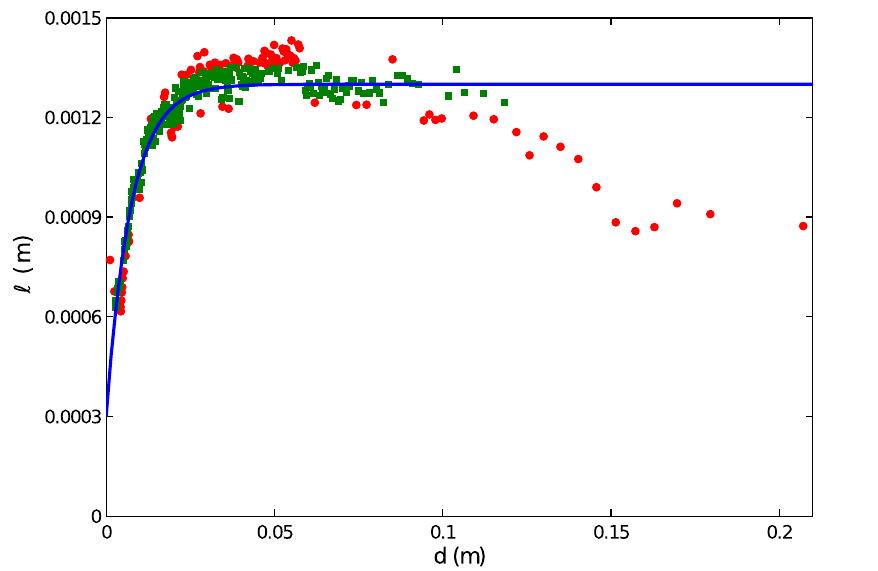
Figure 3. Correlated random walk step length ‘ (in m ) per frame as a function of distance to an aphid’s nearest neighbor d (in m ). Each data point represents the mean step length within a bin of 800 elements from our experimental data set, where the data are binned by d . The overall dependence of the data on d is modeled with Eq. (5), which captures the tendency of aphids to aggregate simply by traveling less when in the vicinity of others. Best fit parameters appear in the text; the coefficient of determination is R 2 =0.82. To give a further sense of the efficacy of the fit, we display data points according to the same scheme used in Fig. 2. Green squares (red dots) represent data bins for which the model prediction falls within (outside) two standard errors of the experimental mean.